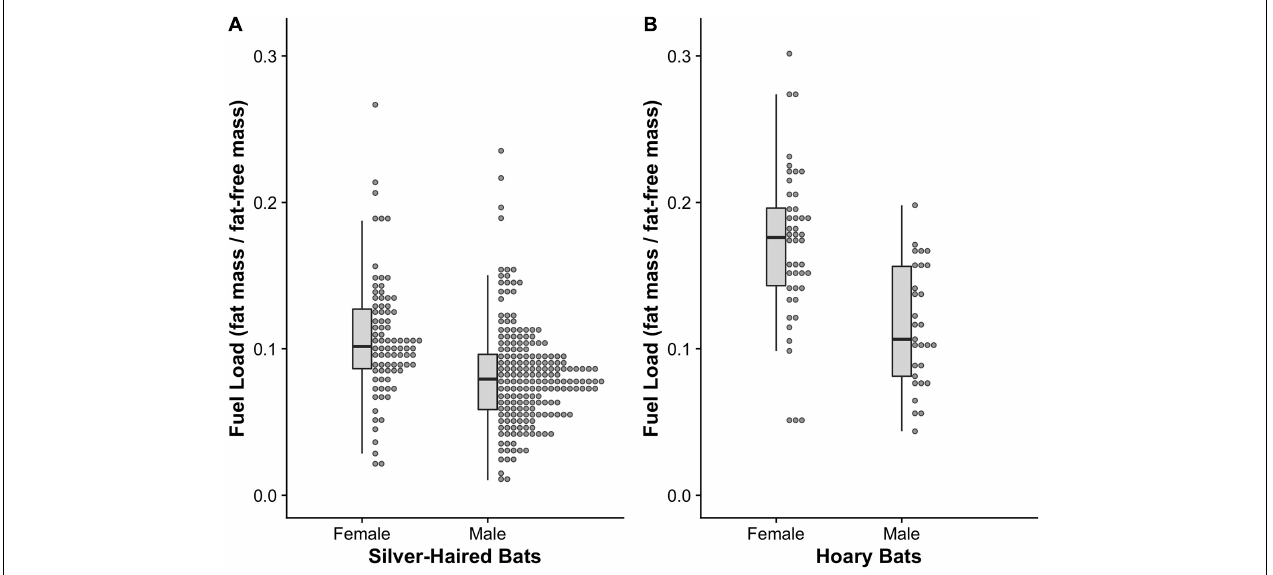
FIGURE 2 | Fuel loads of (A) spring migrating silver-haired bats ( Lasionycteris noctivagans ) and (B) hoary bats ( Lasiurus cinereus ). In both species, female fuel loads were greater than male fuel loads, consistent with optimal migration theory predictions based on females adopting a time-minimizing strategy and males adopting an energy minimizing strategy. Furthermore, the difference in fuel load is greater in hoary bats than silver-haired bats, consistent with predictions based on homeothermic female hoary bats and heterothermy among all others.